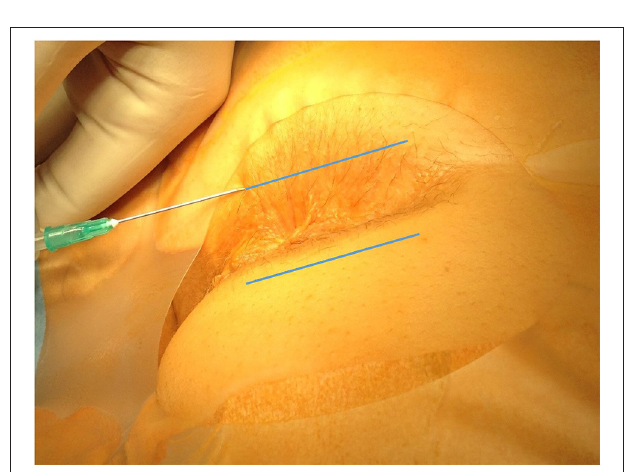
FIGURE 4 | Direction of the third injection (line marks the bearing of the subcutaneous injection).